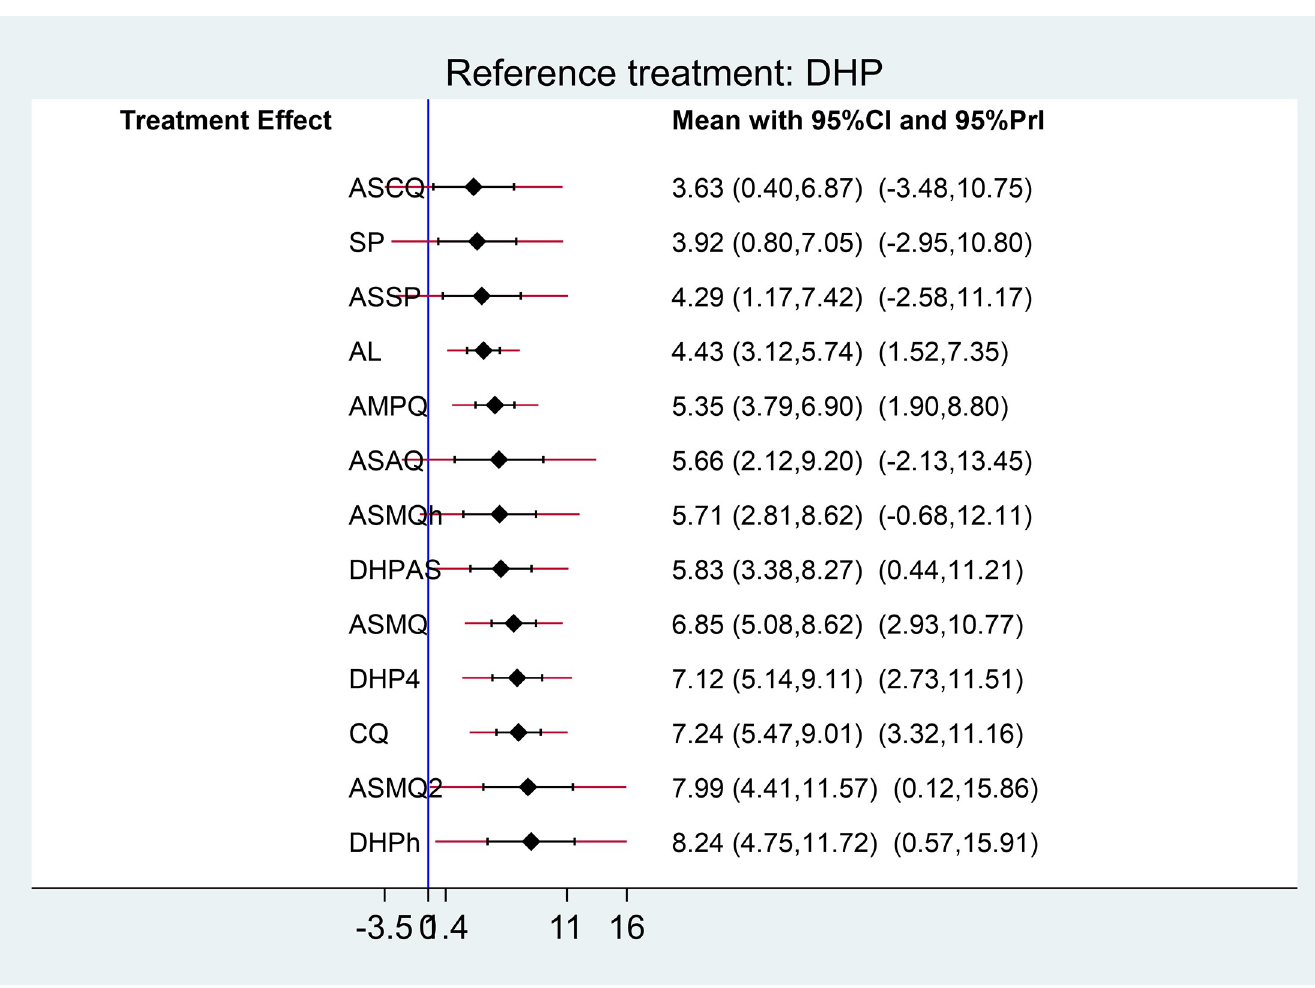
Fig 5. Predictive intervals plot for the antimalarial